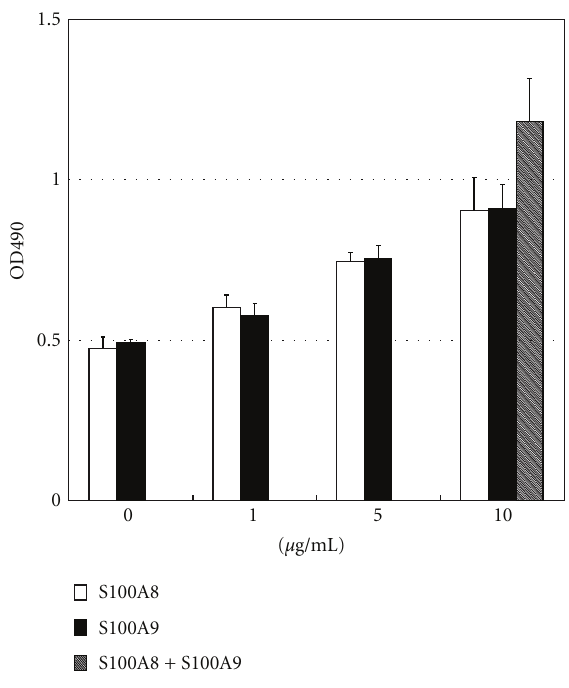
Figure 1: Stimulation of HUVEC proliferation following S100A8 or S100A9 protein treatment at di ff erent concentrations. Shown are representatives of three experiments with similar